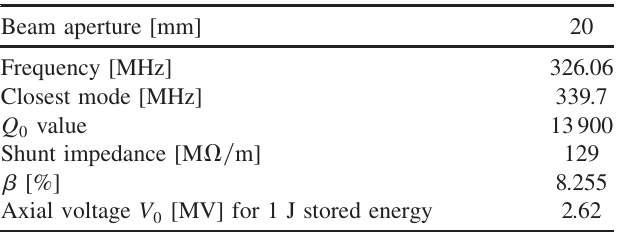
TABLE I. A comparison of the rf parameters for the test model.